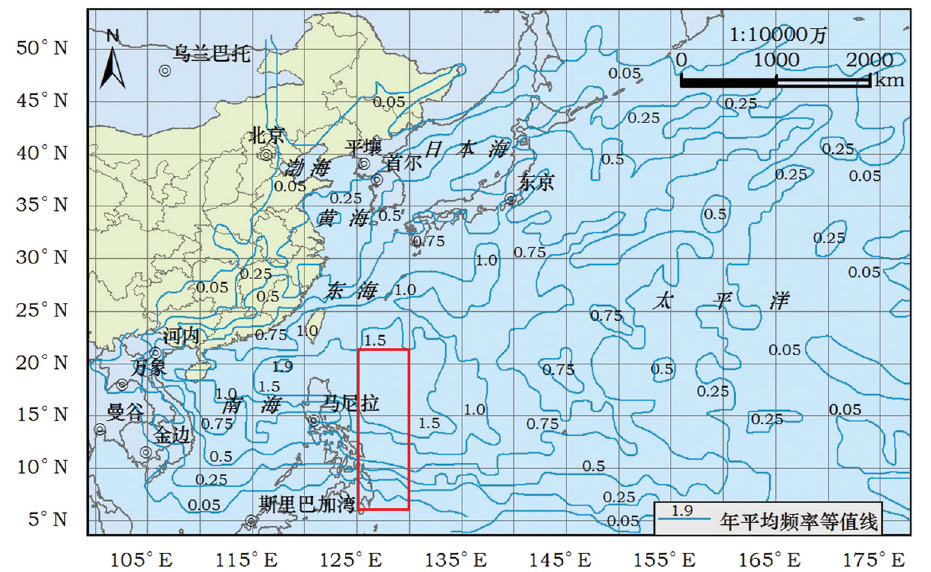
Figure 4: The distribution map of the annual average frequency of tropical cyclones in the Northwest Paci fi c from 1990 to 2009, design coverage area for the task within the red box ( Liu and Liu 2012 ) .